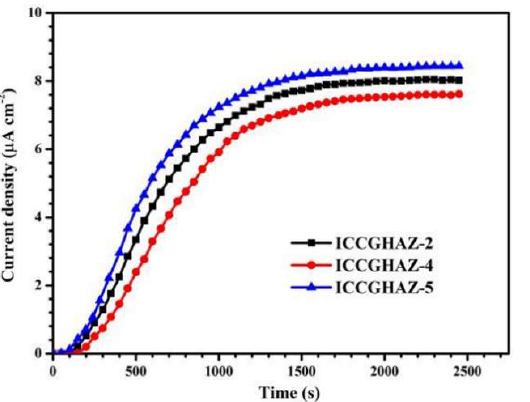
Figure 20. Hydrogen permeation curves of the ICCGHAZs with different cooling rates. Table 4. Hydrogen permeation parameters of the ICCGHAZs with different cooling